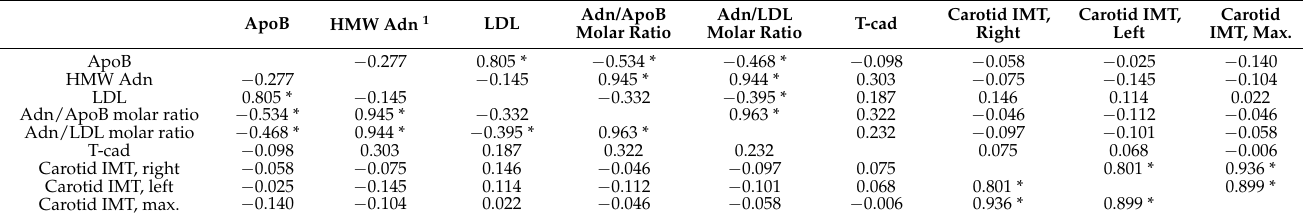
Table A1. Spearman correlation coefficients between carotid IMT and laboratory